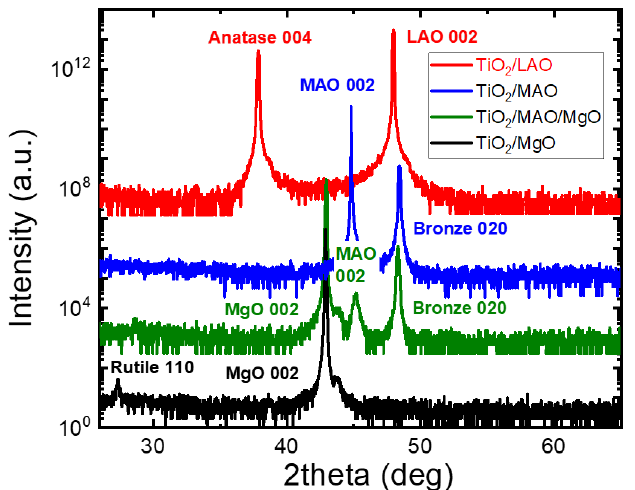
Figure 1. 2 θ - θ scans of TiO 2 films grown on various substrates. While high-quality epitaxial anatase and low-quality polycrystalline rutile are crystallized on LAO and MgO substrates, respectively, it will be shown that phase-pure bronze TiO 2 is stabilized on MAO substrates and buffer layers.